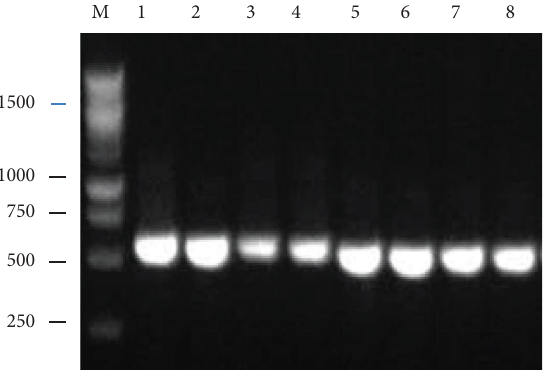
Figure 2: Te visualization of amplifcation PCR (100volts, 30mins). (M) marker, (1) SCBE-1 strain, (2) SCBE-2 strain, (3) SCBE-3 strain, (4) SCBE-4 strain, (5) SCBE-7 strain, (6) SCLE-7 strain, (7) SCLE-8 strain, and (8) SCLE-9 strain.